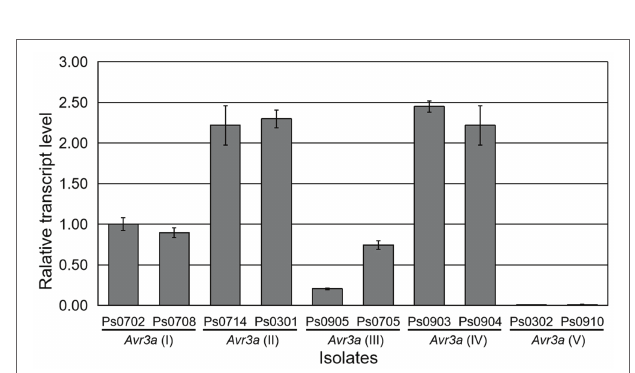
FIGURE 2 | Transcriptional analysis of five Avr3a alleles. Expression levels relative to actin were calculated at 12 h post-inoculation. The PCR reactions were replicated three times. Bars indicate standard